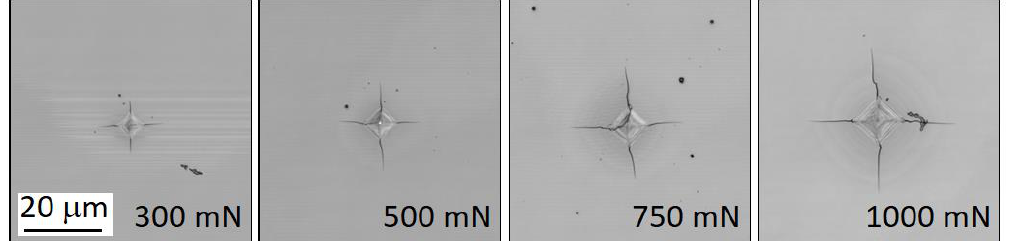
Figure 1. Photographs of indentation with radial cracks. FE model for numerical simulation of the indentation test of Si crystal consisted of a cube with edge length of 200 µ m (Si crystal), Vickers diamond indenter and the load cell, see Figure